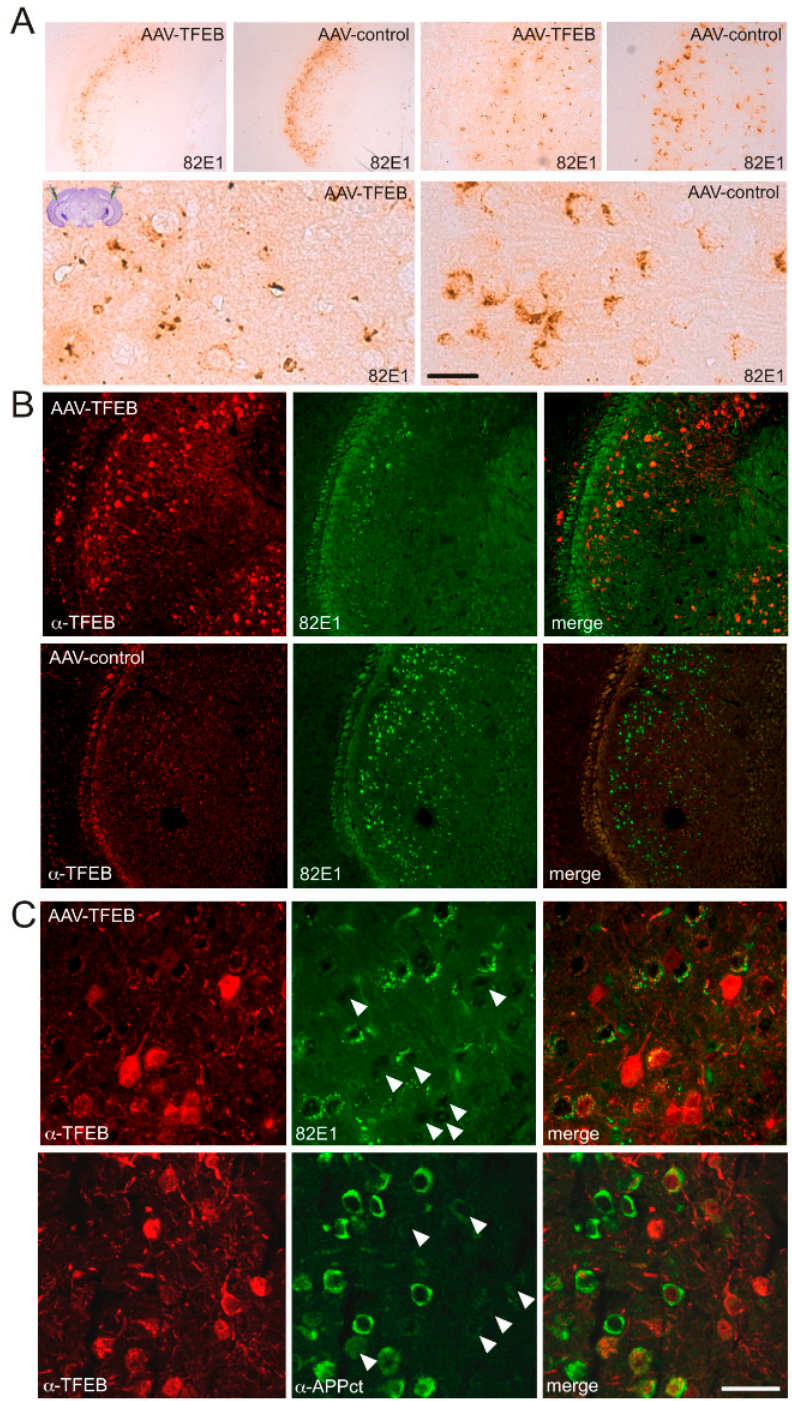
Figure 5. The overexpression of TFEB after stereotaxic injection of AAVs in the subiculum of 3-month-old 3xTgAD mice leads to decreased C99 levels. Mice were analyzed by immunostaining at 8 months of age. ( A ) Low- and high-magnification images illustrating the staining of 82E1 revealed with HRP-conjugated antibodies and DAB in an AAV-cmv-GFP or AAV-cmv-FLAG-TFEB injected mouse at the level of the subiculum. ( B ) Images of immunostaining of TFEB (red) and 82E1 (green) in 3xTgAD mice injected with either AAV-TFEB or AAV-GFP at the level of the subiculum. ( C ) High-magnification images revealing decreased 82E1 and α -APP-ct immunostaining within TFEB positive neurons (arrows). Scale bar: 500 µm), 100 µm and 25 µm in ( A ) and 100 µm and 20 µm in ( B ).